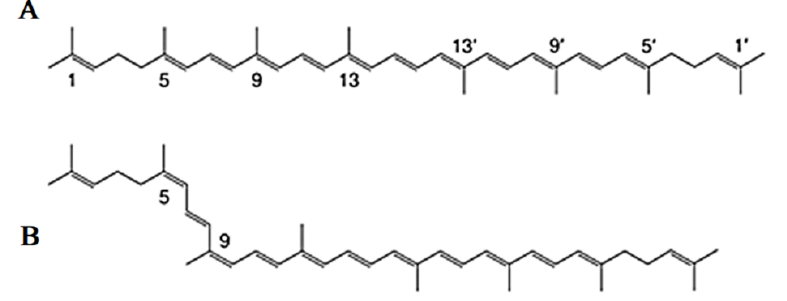
Figure 2. Common isomers of lycopene. ( A ) all-E-lycopene isomer, ( B ) Z-lycopene